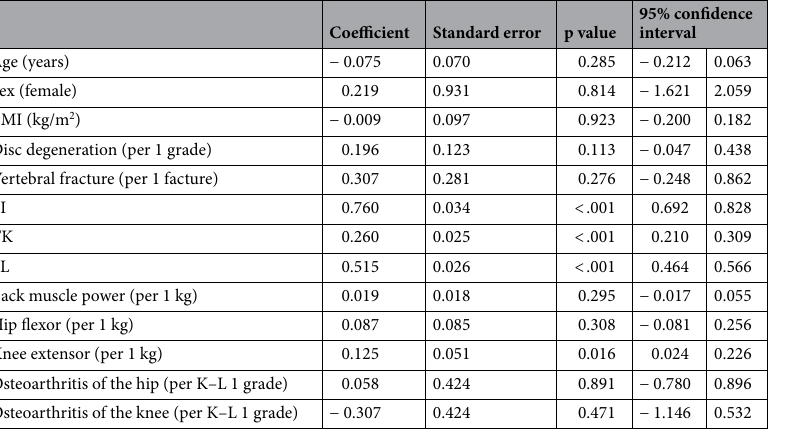
Table 4. Association with pelvic tilt in patients with PI-LL mismatch > 10° using a multivariate linear regression model. The linear regression model was adjusted for age, sex, body mass index, the total disc degeneration, PI, LL, TK, back muscle strength (per 1 kg), hip flexor strength (per 1 kg), knee extensor strength (per 1 kg) and osteoarthritis of the hip and knee (per K–L 1